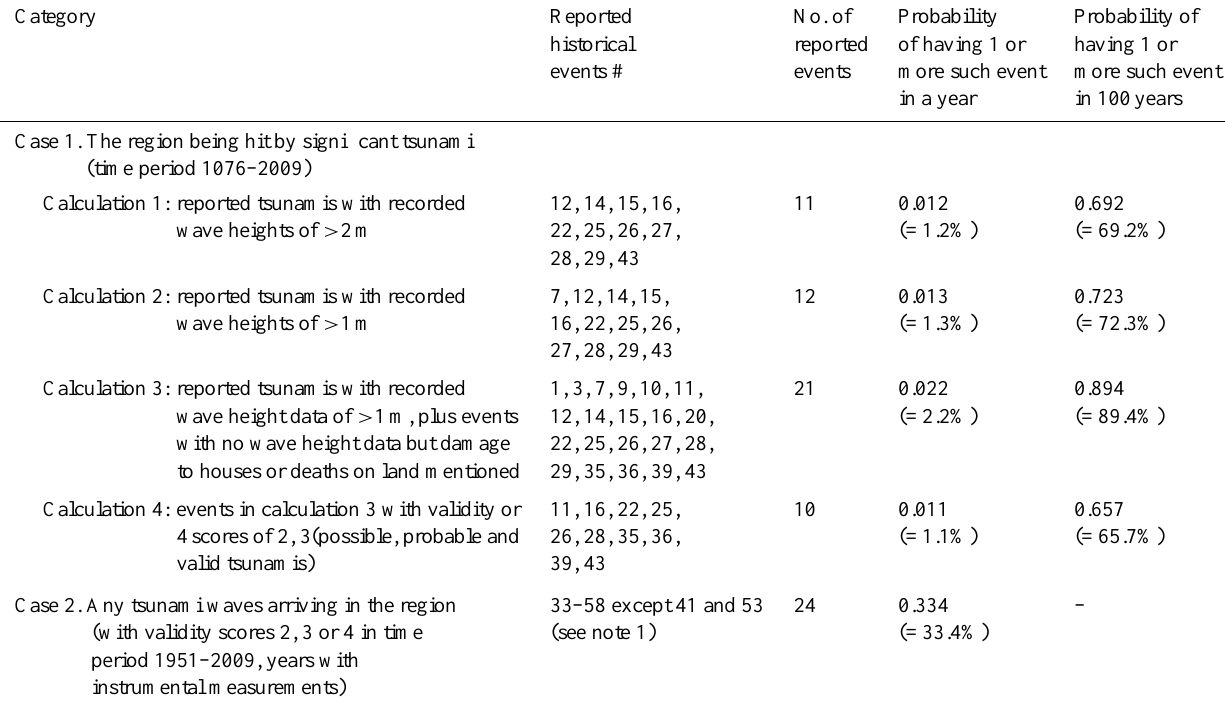
Table 6. Probability of the northeast SCS region being affected by tsunamis, calculated from the occurrence of historical tsunamis in the region using Poisson probability calculations. Note 1 – Besides #35 (0.3–0.66m), #43 (0.3 or 2m), #49 (0.25–0.55m) and #57 (0.10–0.59m), all other events are with wave heights < 0.5m. Refer to Tables S1 and 3 for events details. Category Reported No. of Probability Probability of historical reported of having 1 or having 1 or events # events more such event more such event in a year in